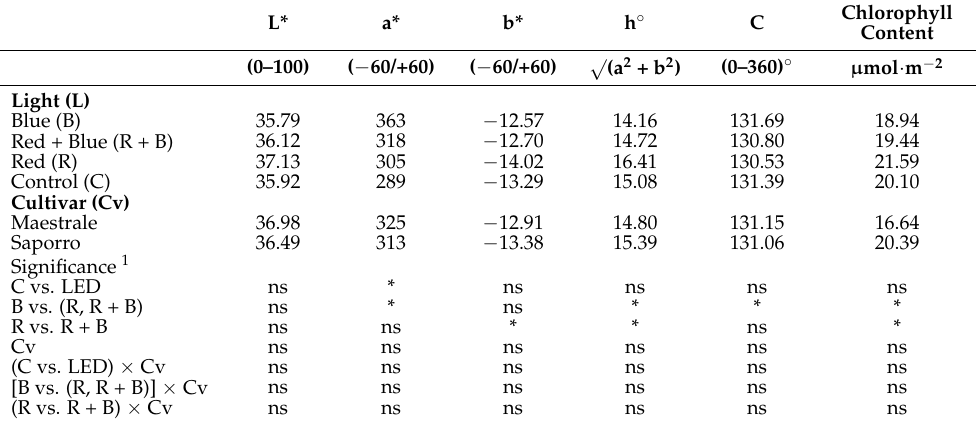
Table 3. Effects of light spectra and cultivar on colour parameters and chlorophyll content of leaves of green beans measured on 4 November